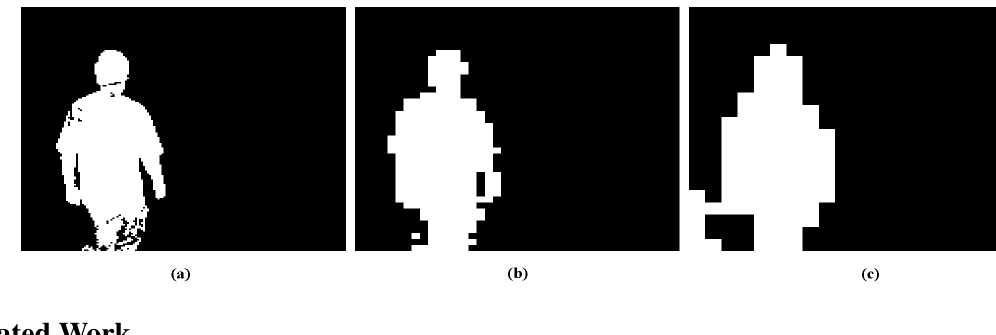
Figure 1. Motion detection at different scales. Finest rectangle size of. (a) 4 × 3 ; (b) 16 × 12 ; and (c) 32 × 24